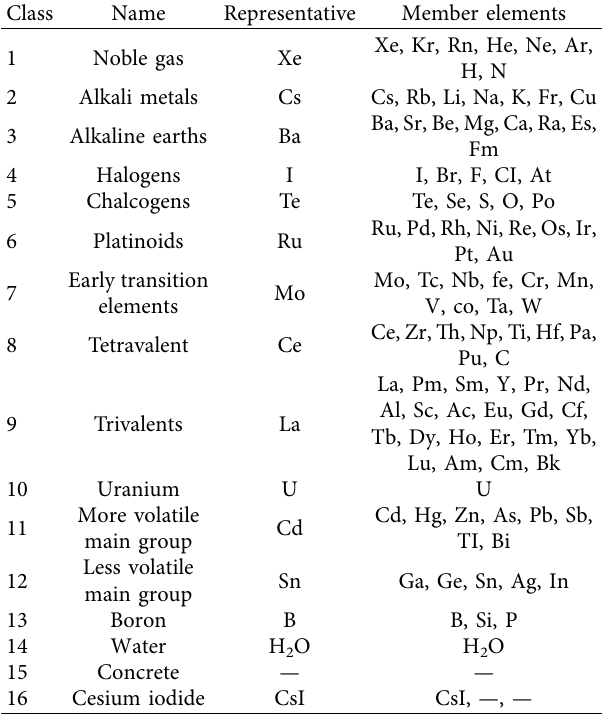
Table 3: Grouping of materials in the MELCOR.